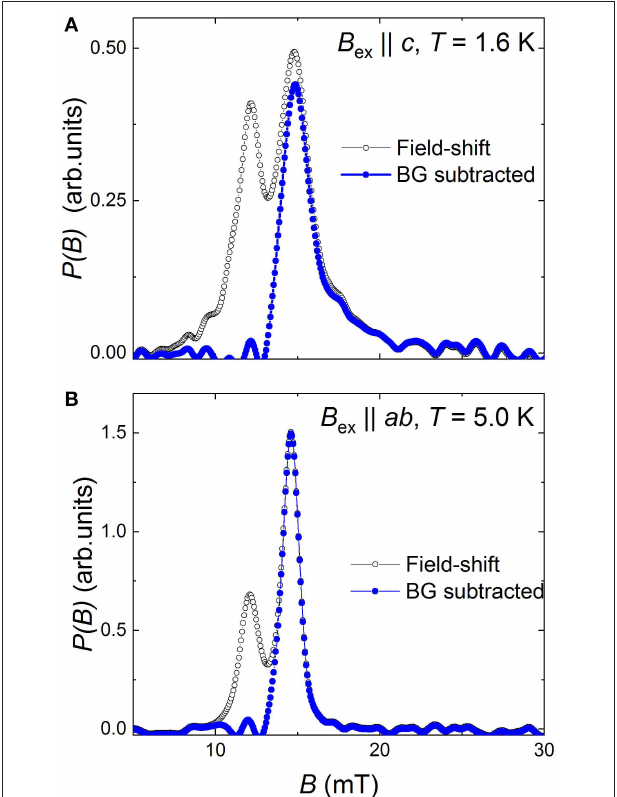
c (A) and B ex ab (B) set of k k